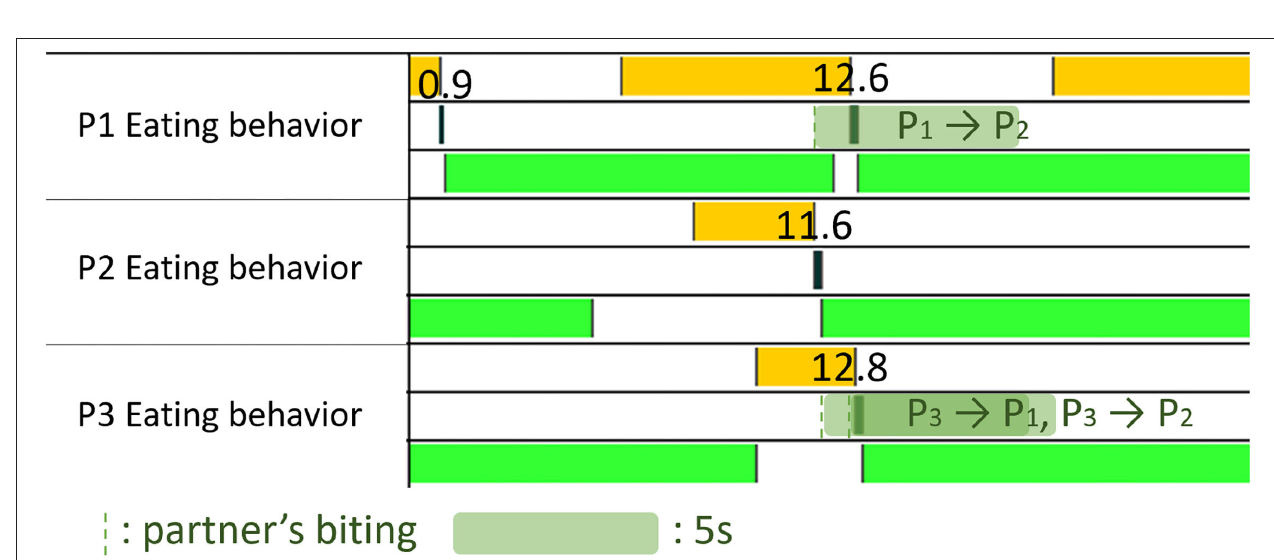
FIGURE 3 | Synchronized biting of P 1 → P 2 , P 3 → P 1 , and P 3 → P 2 . Synchronized biting P i → P j was defined as participant i taking a bite within 5 sec of participant j taking a